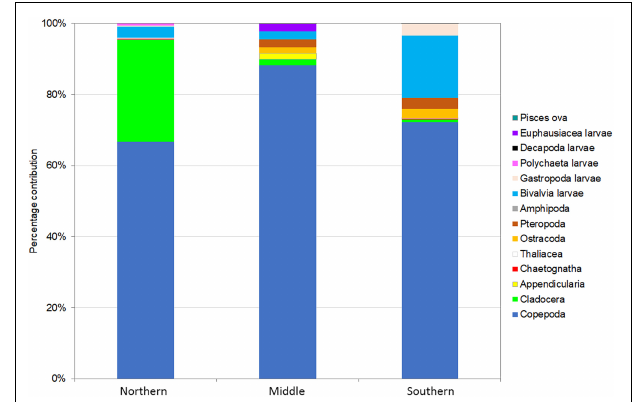
FIGURE 3 | Abundance contribution (%) of zooplankton sampled from the three study areas of the Adriatic Sea.